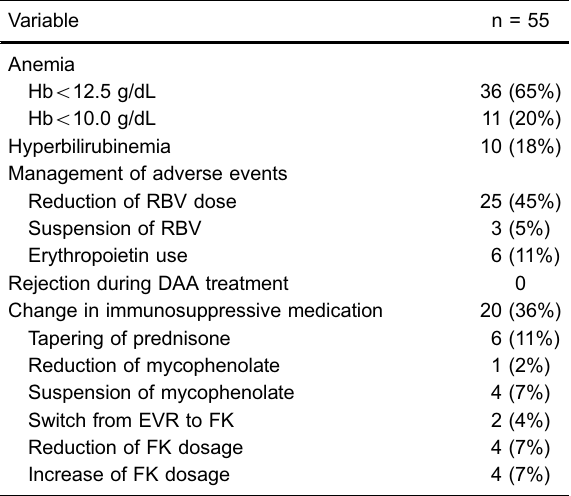
Data are reported as n and percent within parentheses. Hb: hemoglobin; RBV: ribavirin; DAA: direct-acting antiviral; FK: tacrolimus; EVR: everolimus.